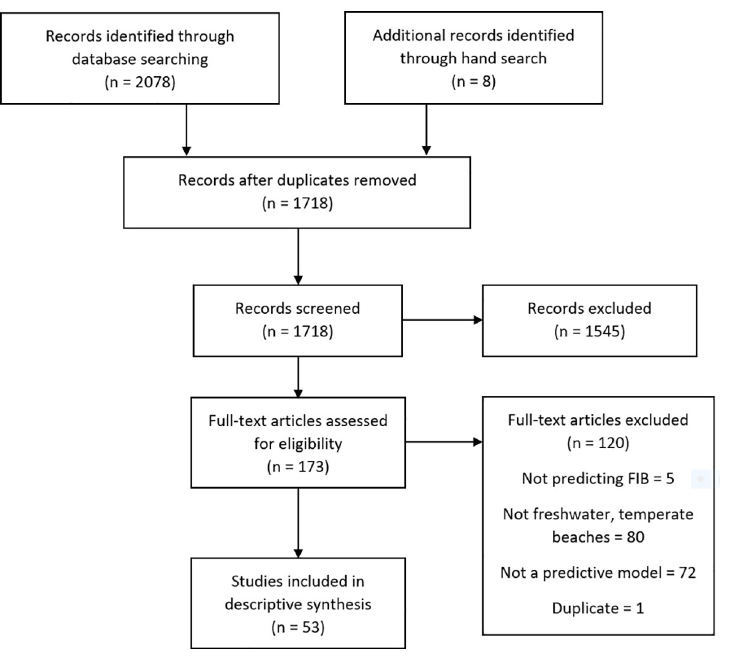
Fig 1. PRISMA flow diagram of article